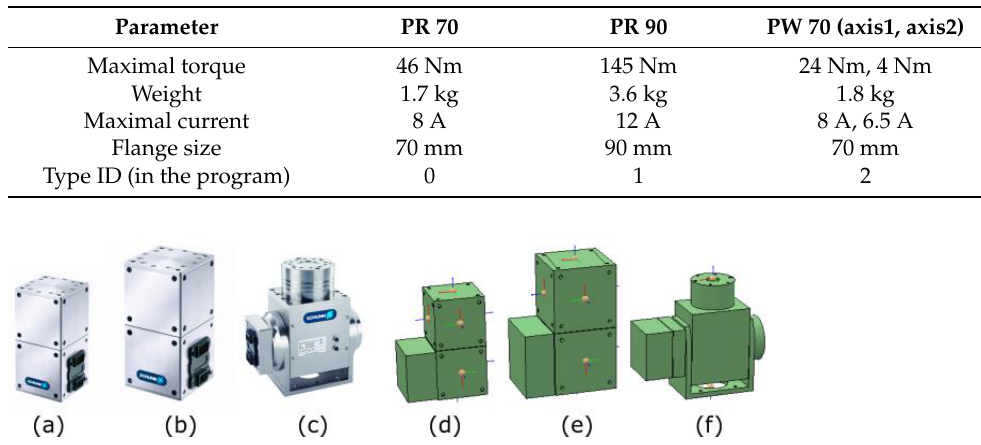
Table 1. Joint module physical parameters.